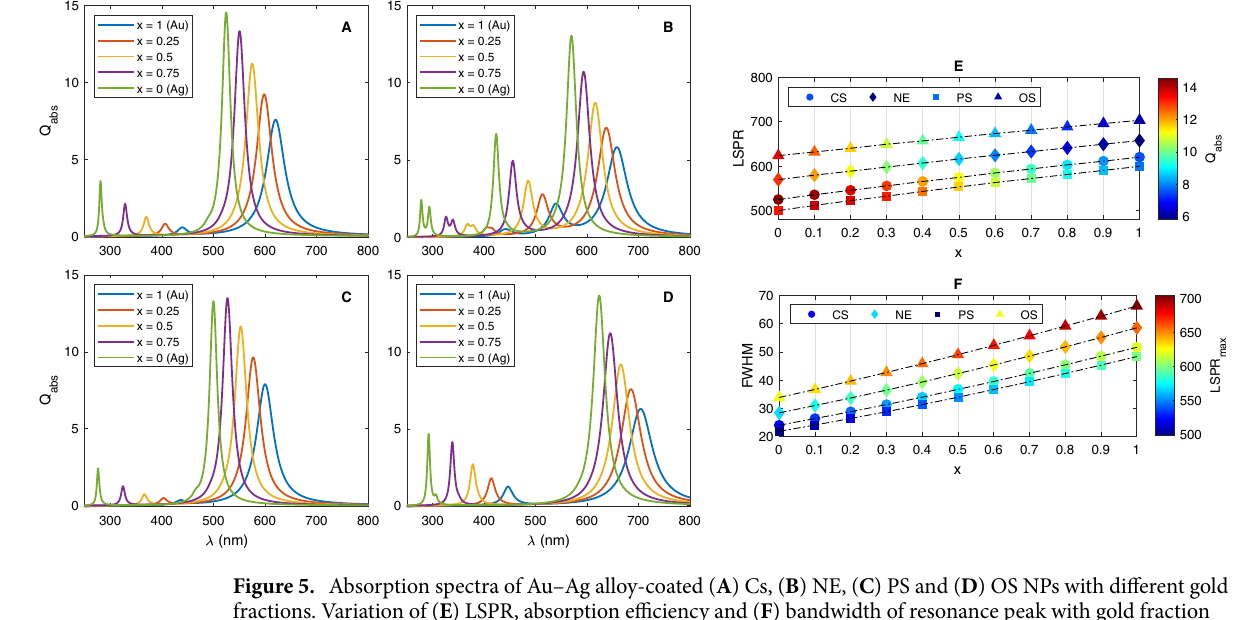
Figure 5. Absorption spectra of Au–Ag alloy-coated ( A ) Cs, ( B ) NE, ( C ) PS and ( D ) OS NPs with different gold fractions. Variation of ( E ) LSPR, absorption efficiency and ( F ) bandwidth of resonance peak with gold fraction in the alloy as shell material. The total radii of SiO 2 @ Au x Ag 1 x are fixed at 20 nm and a dimension of each core − have been chosen so that the volume of core is equal to that for a 15 nm radius sphere.